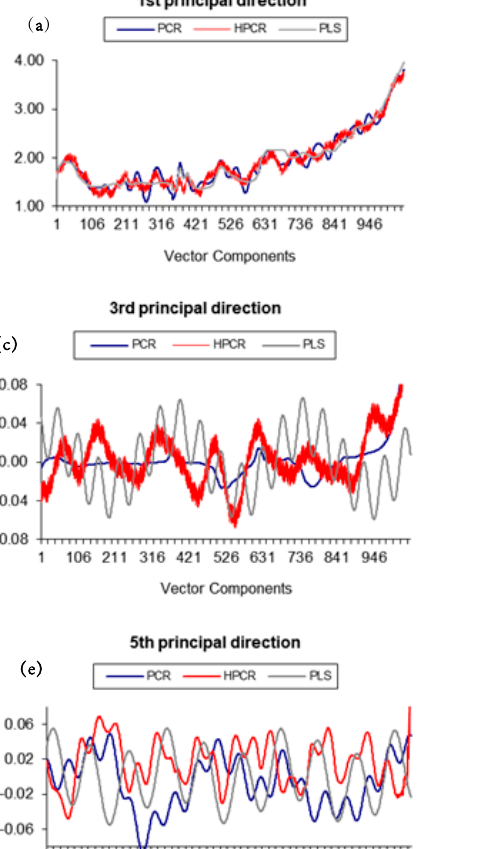
Figure 7. Calibration objective functions for PLS, PCR and HPCR models at 90 °C and 450 rpm.